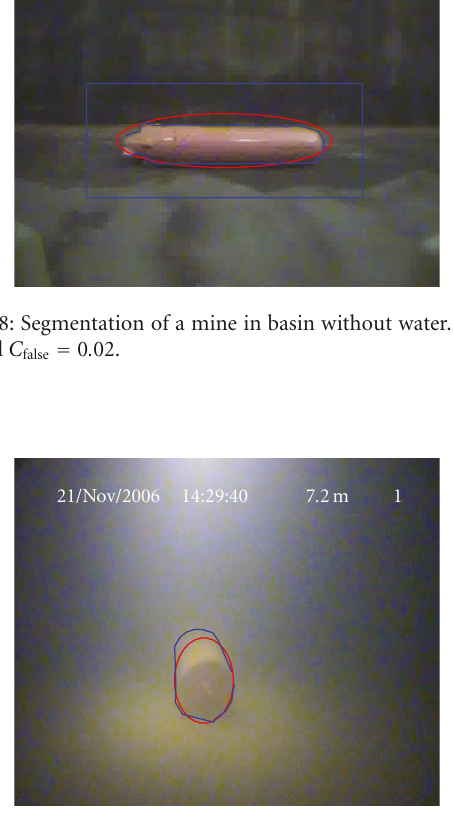
Figure 7: Segmentation presented on the real image. In red the obtained segmentation, in blue the ground true. The blue square is the area of interest which can be used for the recognition step.